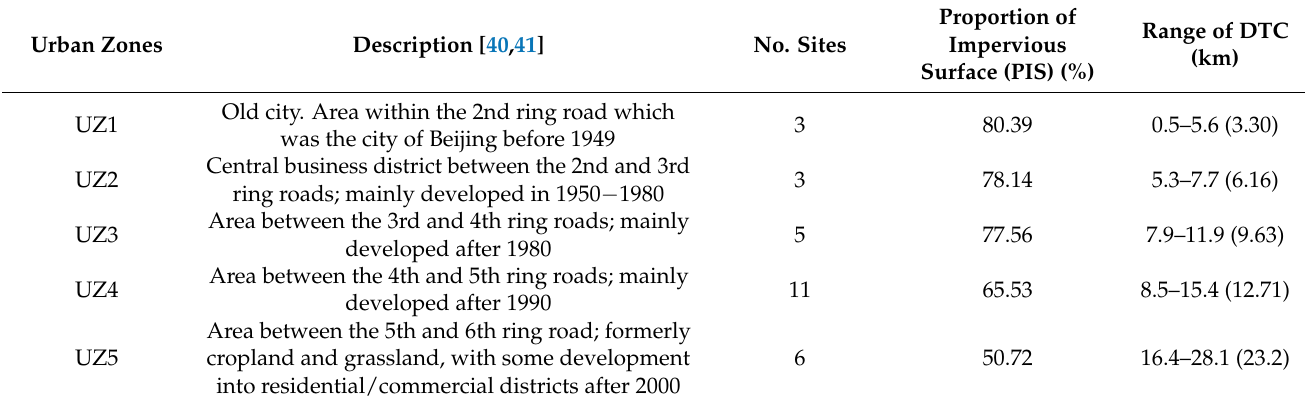
Table 1. Descriptions of the five urban zones divided based on the ring-road systems of Beijing [35].